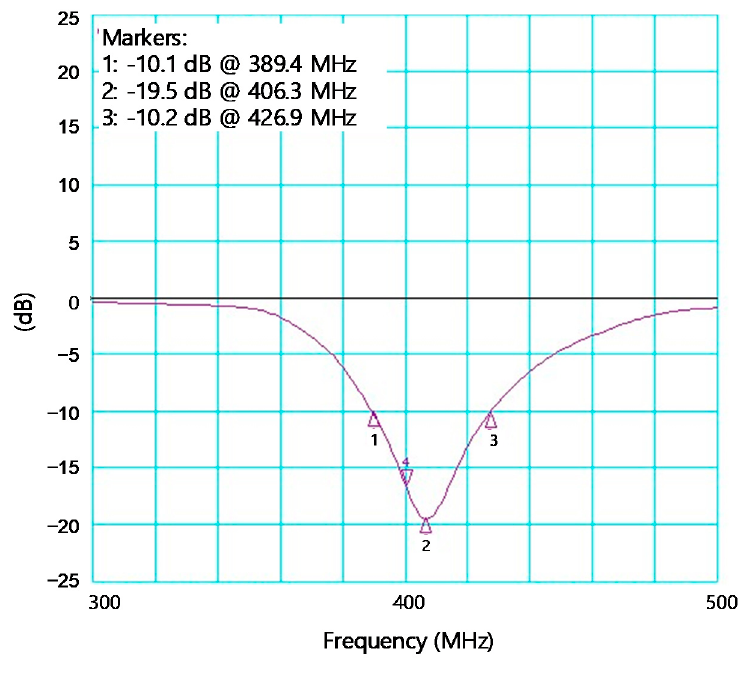
Figure 8. Measured S 11 of the receiver.